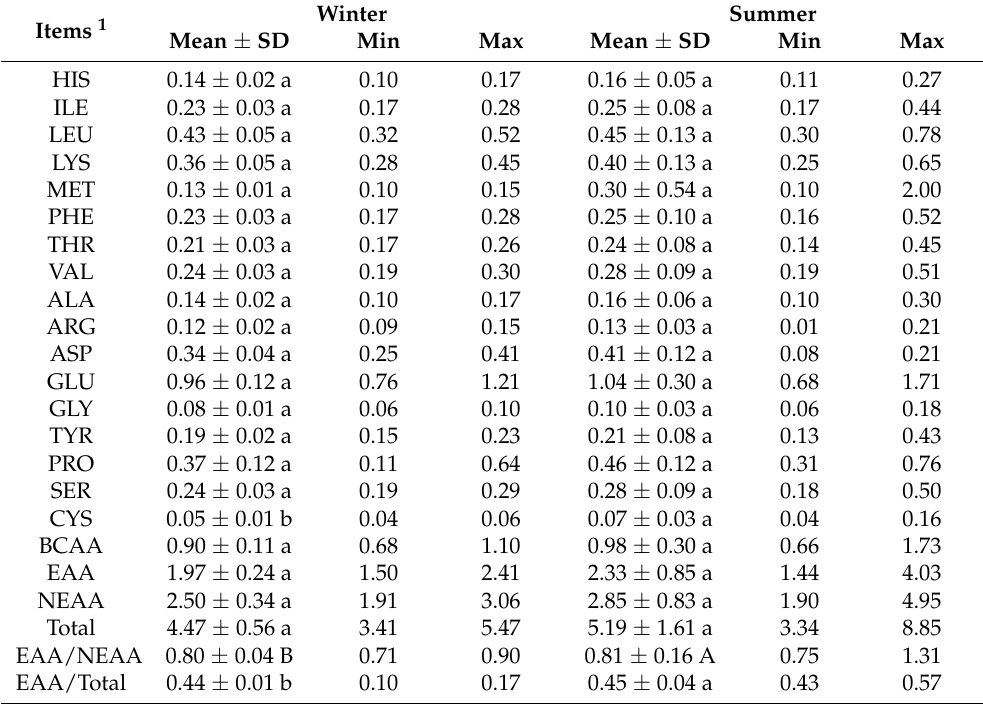
Table 5. Mean (g/100 g of amino acid) ± SD and range of individual amino acid and amino acids groups of crossbred buffalo raw milk in winter and summer. Items